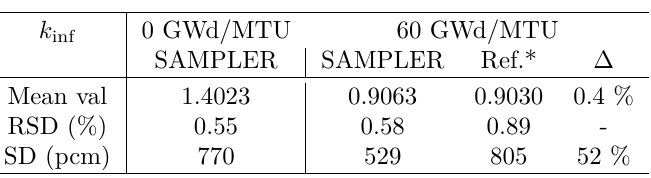
inf for cases UAM* (using 44groupcov) and SAMPLER